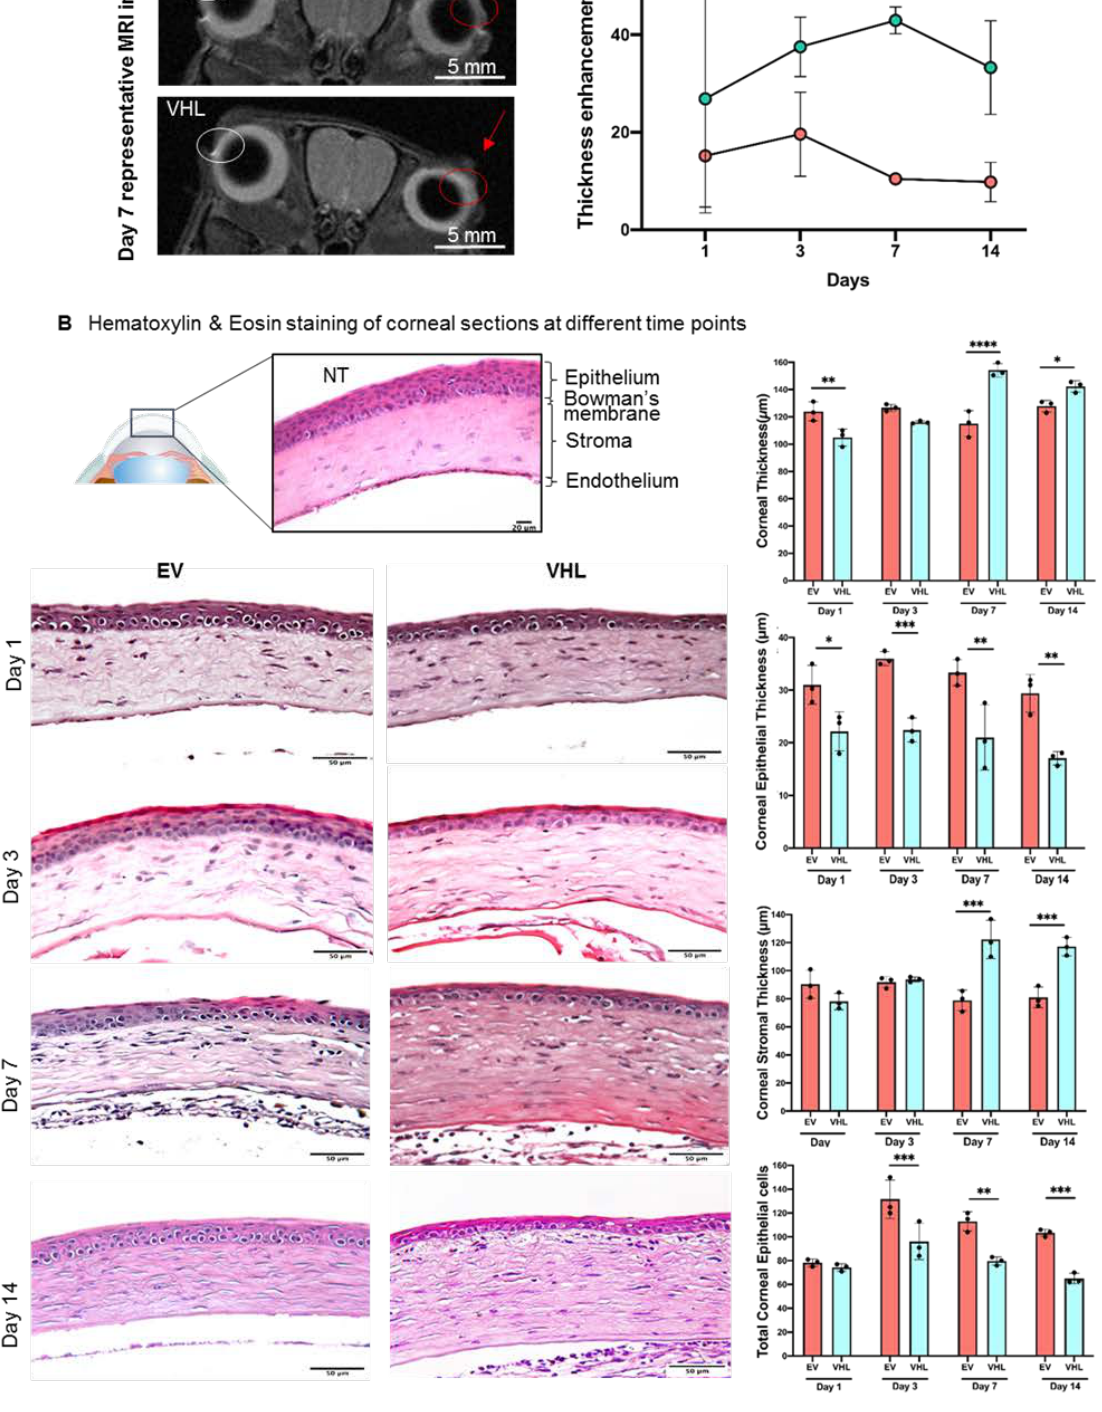
Figure 3. MRI-based and histological analyses of injured corneas. ( A ) MRI T2w-based time course analysis of corneal thickness following treatment with BMSC-EVs and VHL. Representative images obtained at day 7 post BMSC-EV treatment versus VHL control is shown. The damaged eye